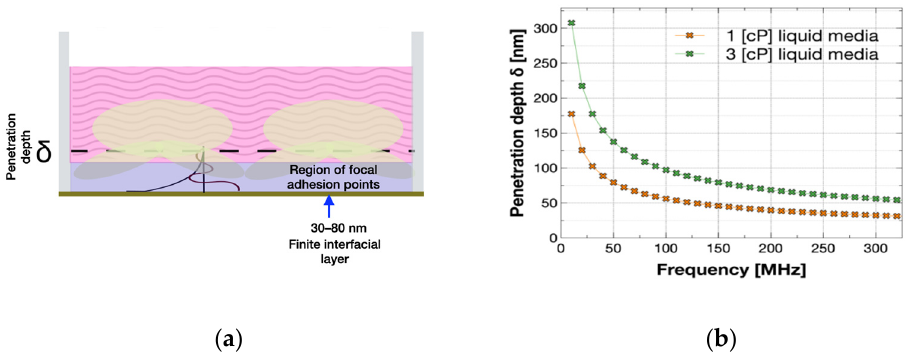
Figure 1. ( a ) Cell monolayer modeled by two-layer material that represents the focal adhesion region, and a bulk region beyond the focal adhesion: a finite interfacial layer (in violet) found between 30 and 80 nm, followed by a semi-infinite bulk region (in pink). This cell monolayer representation is based on the models used by H. Wu and Fang Li where cell viscosities are estimated in ranges between 1.5 and 2.2 cP [1,2,5]. ( b ) Penetration depth of horizontal polarized waves in liquid media as function of frequency for 1 cP and 3 cP viscosities in liquid media with a density of 1000 kg/m 3 . These graphs were computed with the formula δ = [4,6,7] where δ is the penetration depth, η liq , the viscosity, ρ liq the density of the liquid, and f 0 the shear wave frequency. It can be seen that the penetration depth of waves in water-like liquid of 1 cP at 100 MHz is confined to around 50 nm, while for 30 MHz the penetration of acoustic waves is close to 100 nm.